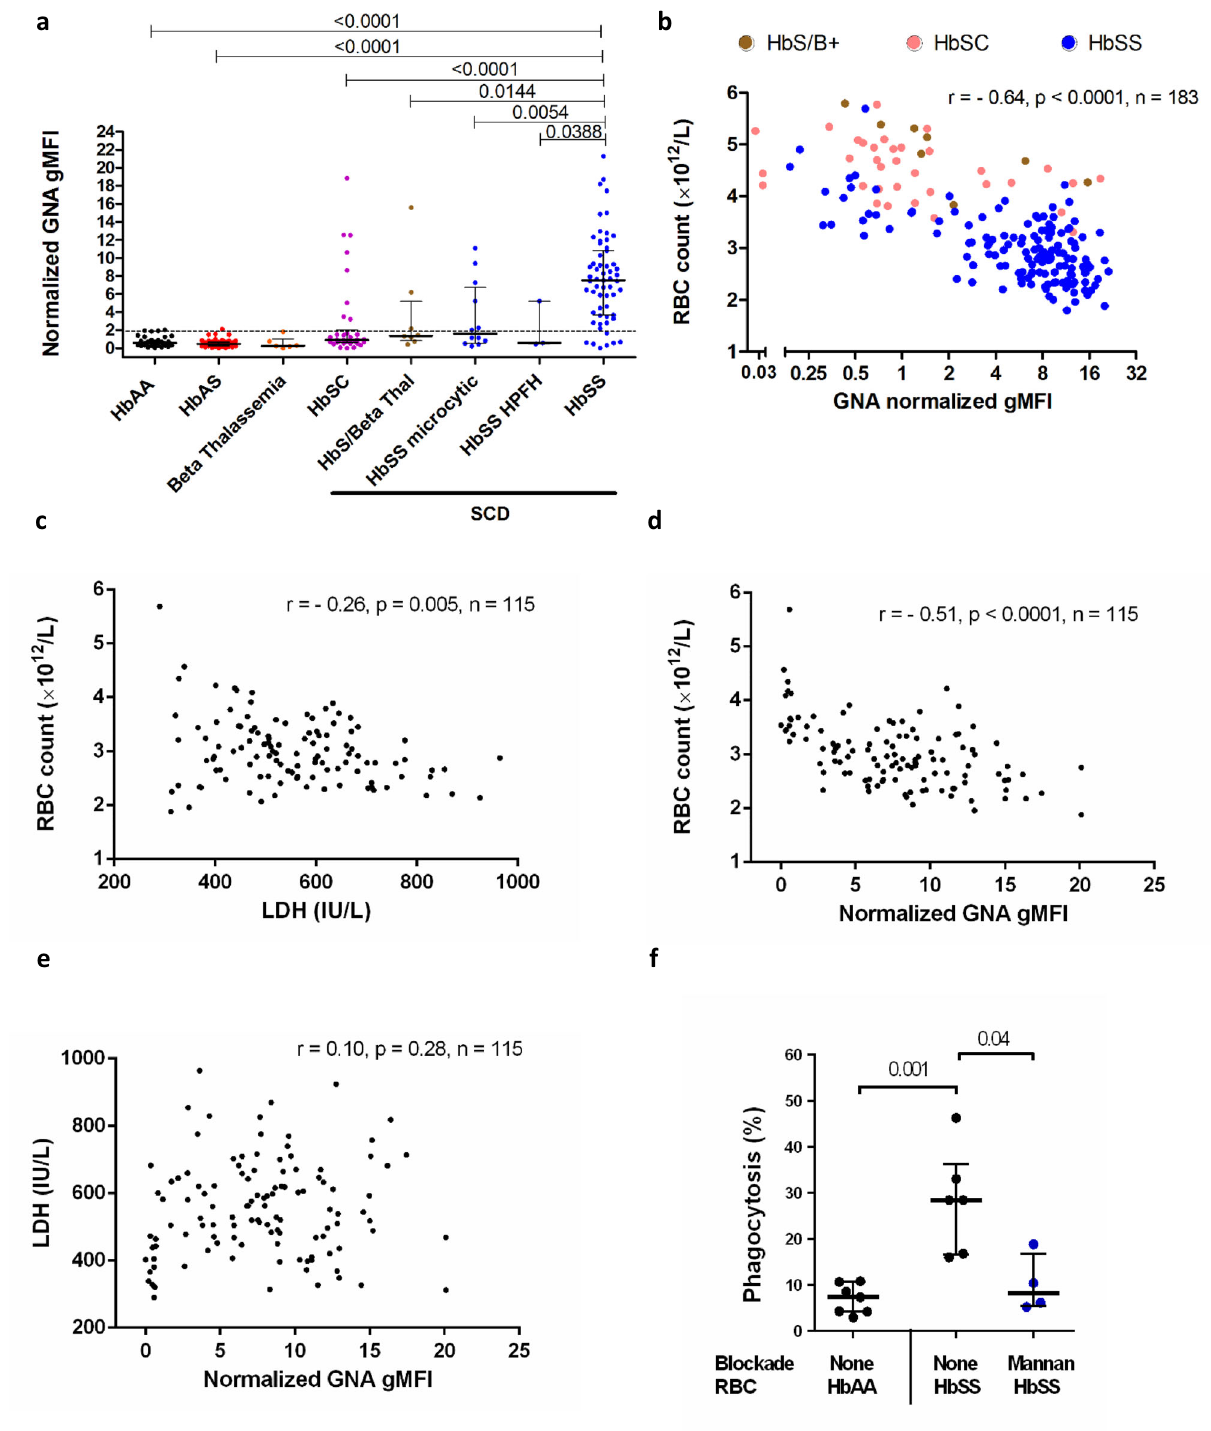
(Fig. 3c). We also observed that in cultures of oxidized RBCs with human monocyte-derived macrophages (HMDM) in vitro, uptake was restricted to MR positive cells (Fig. 3d). Furthermore, siRNA knockdown of MR in macrophages (Supplementary Fig. 6c) speci fi cally reduced phagocytosis (Fig. 3e, Supplementary Fig. 6d); and phagocytosis was also inhibited by the competing glycans mannan or chitin, each known to block MR-CRD, 19 but not inhibited by the control glycan laminarin (Fig. 3f, Supple- mentary Fig. 6e). Finally, MR-CRD-blocking antibody also inhibited phagocytosis of both oxidized healthy and native